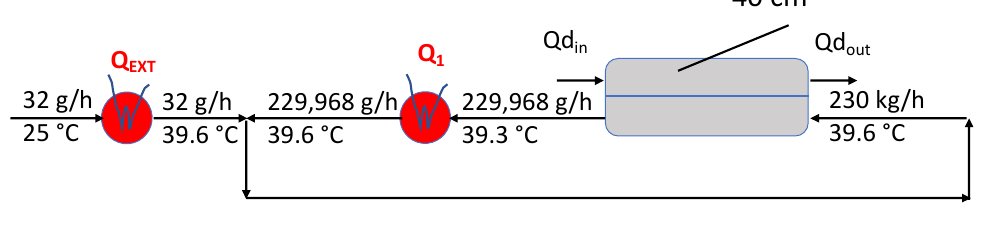
Figure 5. DCMD flowsheet.